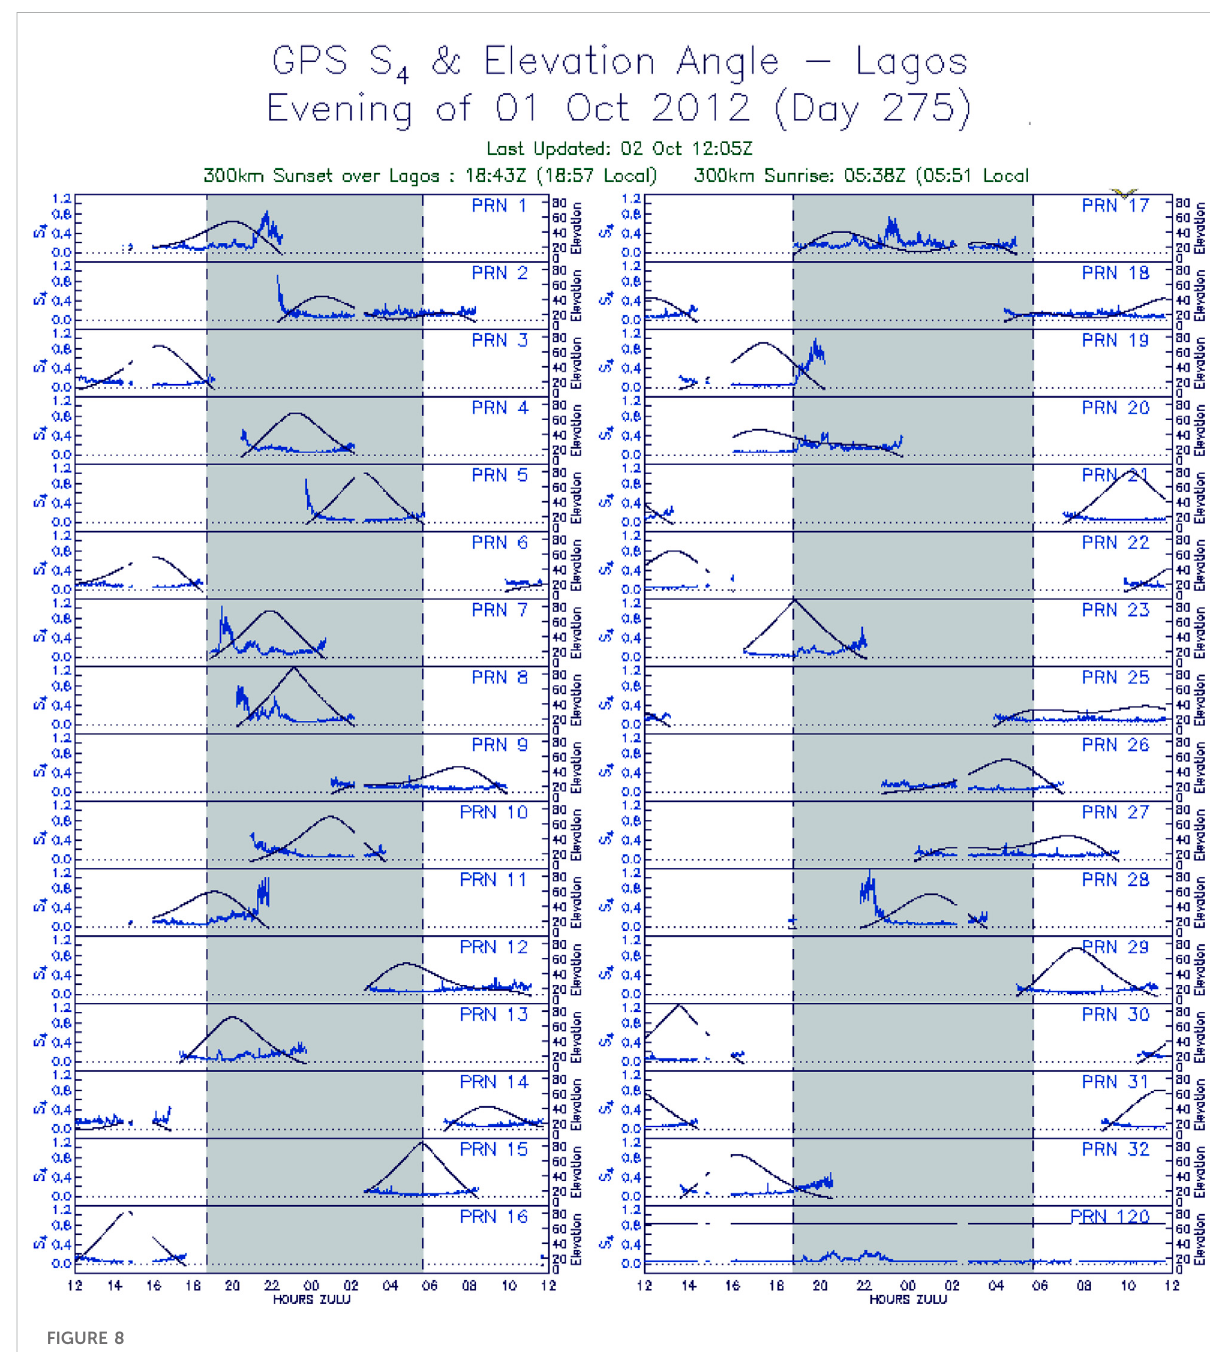
FIGURE 8 Scintillation plots per satellite for the Lagos SCINDA GPS receiver, with coordinates: 6.5166646 3.38499846, for 1 October